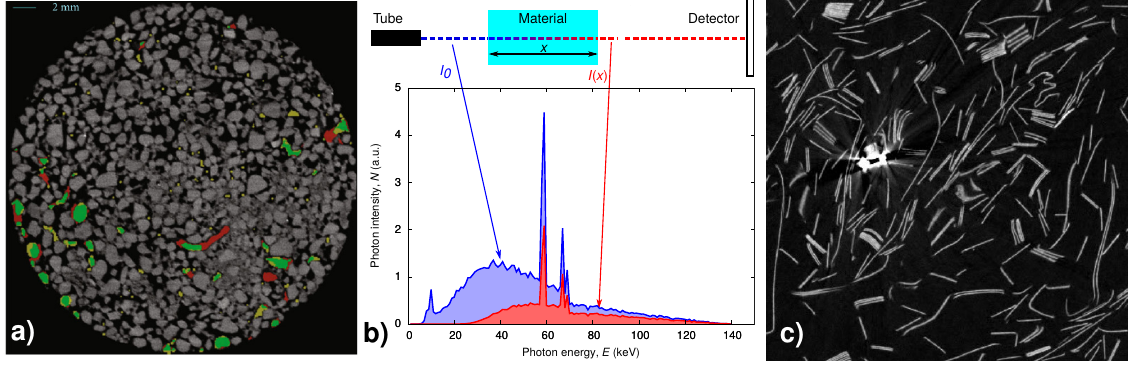
Figure 3: Challenges in X-ray imaging. a) Material mixtures, which do not differ significantly in their attenuation coefficients, can only be segmented by error-prone subsequent image processing. The panel shows as an example a cross-section through a container with plant roots in soil using two different algorithms to identify the root: green areas are roots found by both algorithm, red and yellow areas are found by only one of the two (adapted from [62]). b) Beam hardening arising from the energy dependent attenuation of X-rays: The photon spectrum in front and behind a sample differ qualitatively. This change is not accounted for by the algorithms presently used to compute tomographic images (adapted from [63]). c) The panel shows a cross-section of a tomography of paper clippings. The white area with the radially extending white streams is a beam hardening artifact originating from (but not identical to) a metal paperclip contained in the sample. This type of beam hardening artifact occurs if the sample contains particles made from a material with a higher periodic number than the